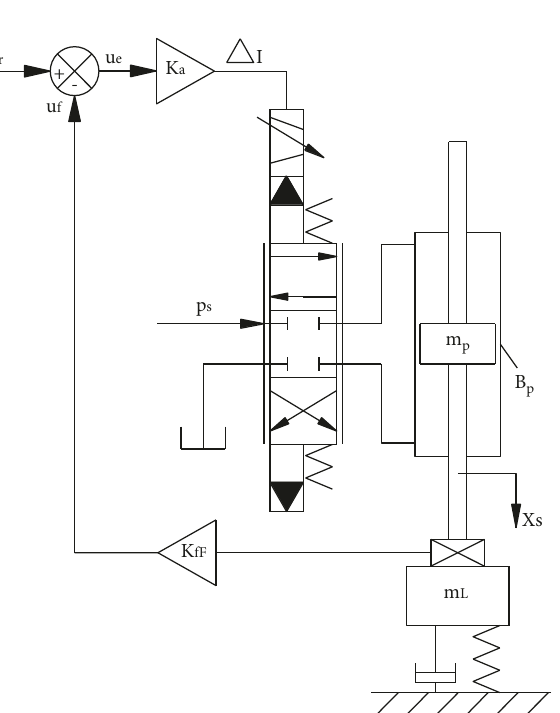
Figure 3. The block diagram of the machine’s hydrostatic guide control system is shown in Figure 4.